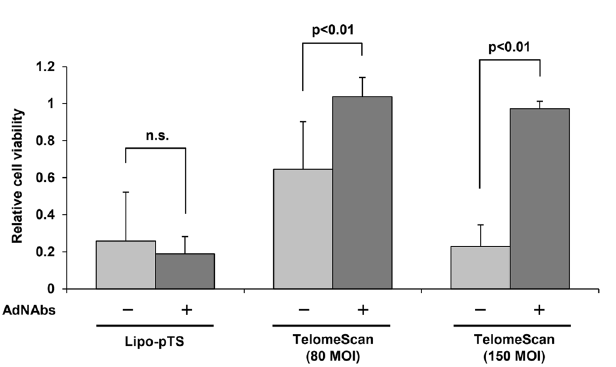
Figure 5. The stealth effect of Lipo-pTS providing protection from adenovirus neutralizing antibodies in vitro . HCT116 cells are treated with Lipo-pTS or TelomeScan in the presence or absence of adenovirus neutralizing antibodies for 3 days, and cell viability is examined by the XTT